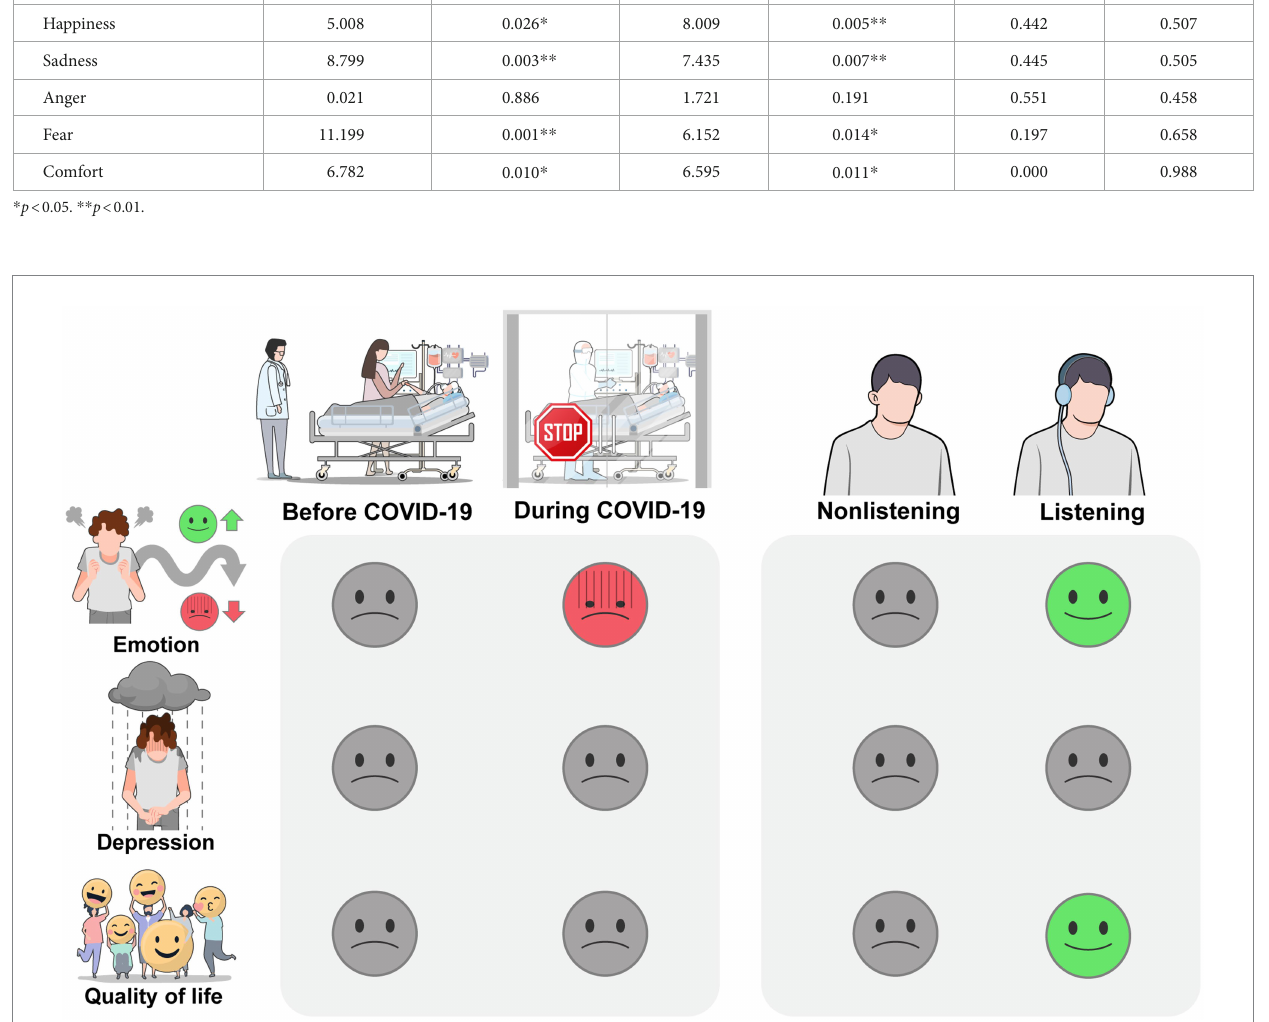
FIGURE 1 Self-reported psychological well-being of family caregivers of ICU patients before and during the COVID-19 pandemic and whether currently engaging in music listening. During COVID-19, the emotional states as an acute response to current stressors were significantly more negative, and current engagement in music listening showed a significant change in the opposite direction. For perceived depression as a more chronic mood state, time point and current engagement in music listening did not result in significant changes. For quality of life, which is a general perception of